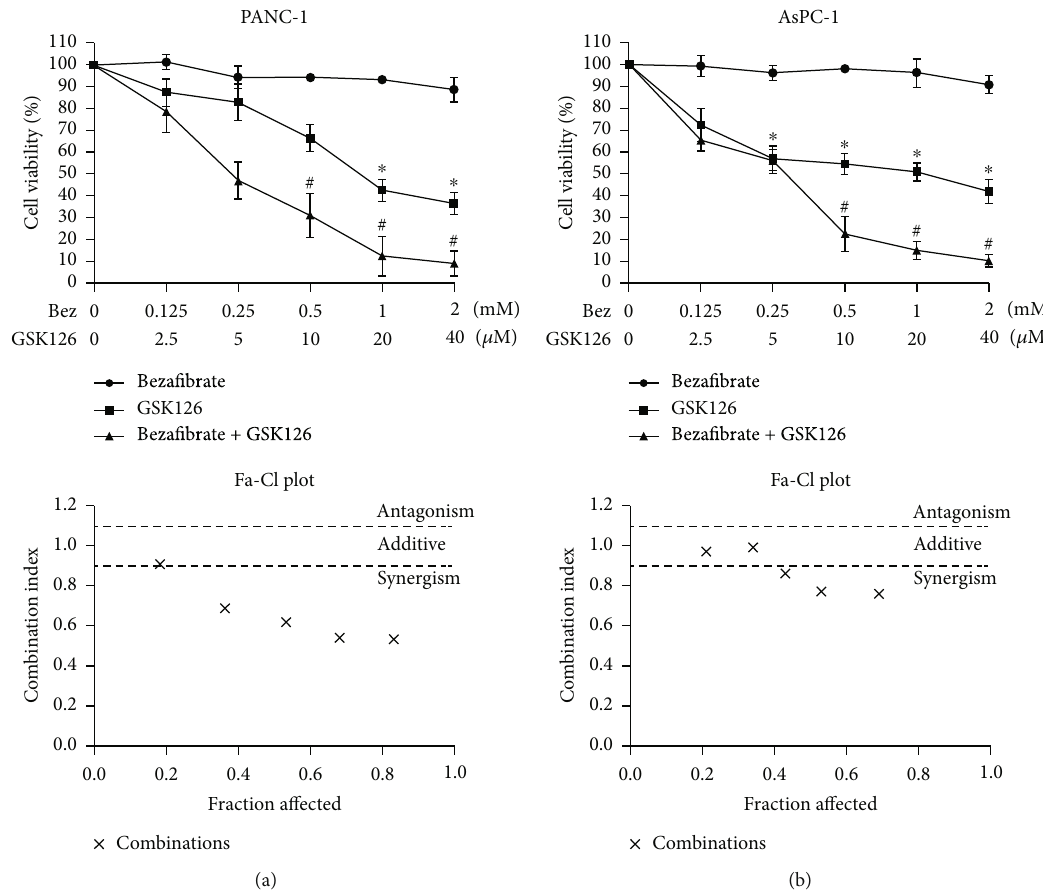
Figure 2: E ff ects of combination of beza fi brate and GSK126 on cell viability of PANC-1 and AsPC-1. (a) E ff ects of di ff erent concentrations of beza fi brate, GSK126, and their combination on cell viability of PANC-1 after 120h treatment. Combination indexes were calculated accordingly on the indicated concentrations of beza fi brate and GSK126. (b) E ff ects of di ff erent concentrations of beza fi brate, GSK126, and their combination on cell viability of PANC-1 after 120 h treatment. Combination indexes were calculated accordingly on the indicated concentrations of beza fi brate and GSK126. The values were expressed as the means ± S : E : M : ( n = 6 for each group). ∗ P < 0 : 05 vs. the beza fi brate group; # P < 0 : 05 vs. the GSK126